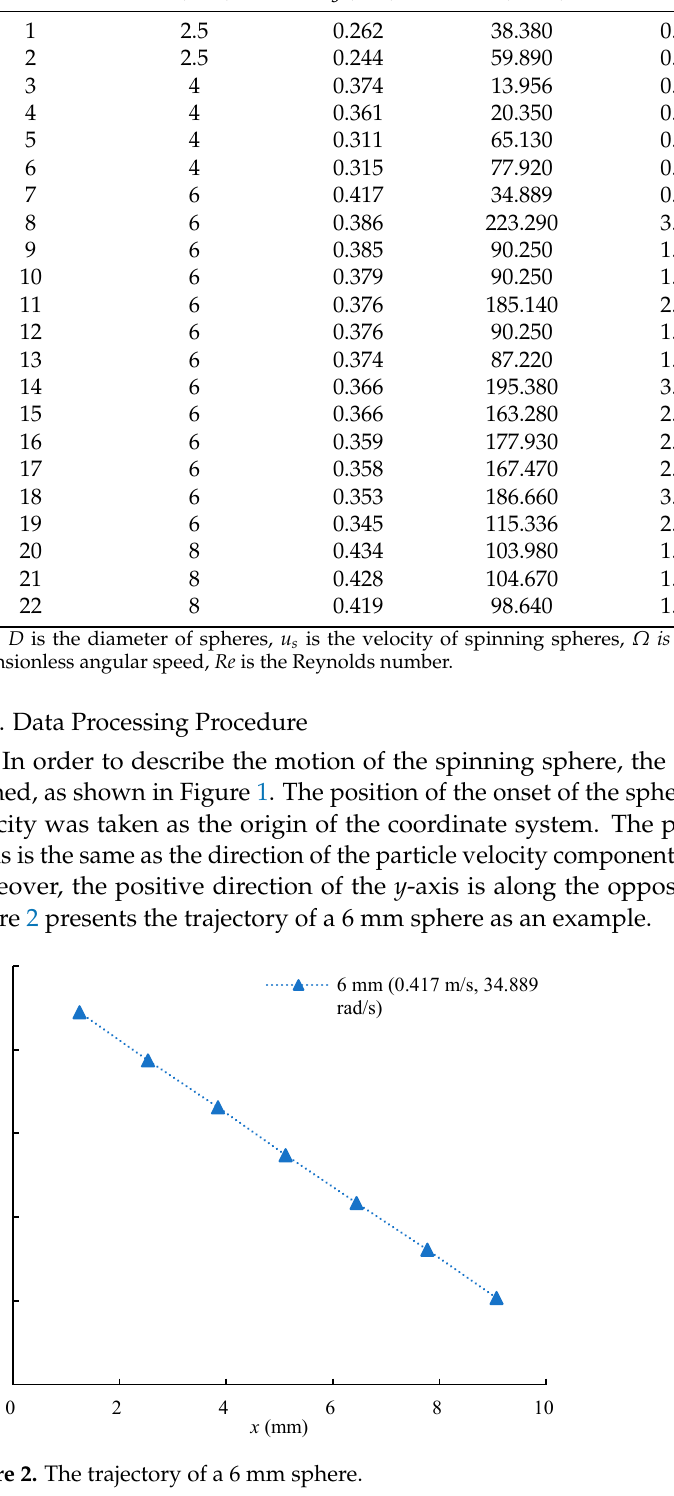
Figure 3. The velocity of a 6 mm sphere. The motion of spinning spheres is mainly affected by submerged weight, drag force, and lift force, as shown in Figure 4. Since the fluid is stationary, the velocity of the fluid u = 0. Therefore, the relative velocity between the particle and fluid u r is equal to the veloc- ity of the spinning sphere u s . The drag force is in the opposite direction of the sphere’s motion.